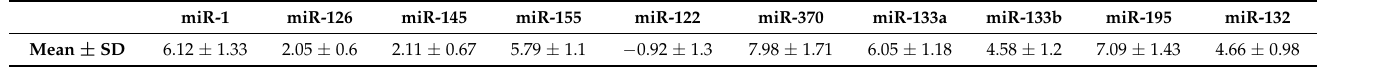
Table 2. Plasma levels of